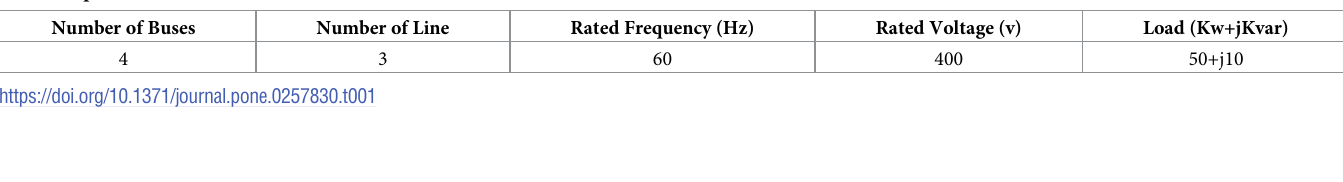
Table 1. Specifications of the studied